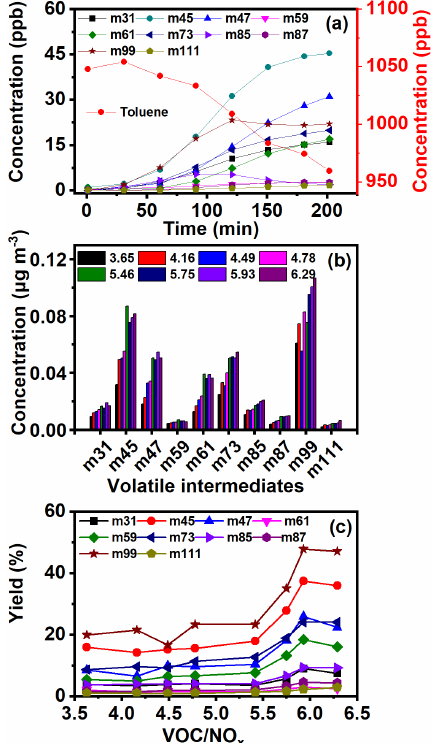
. Figure 6. (a) Intermediate concentration variation along with the re- action time under 1048ppb of toluene and 162.0ppb of NO x , (b) in- termediate concentration, and (c) yield from toluene photochemical oxidation with the increase of the VOC / NO x